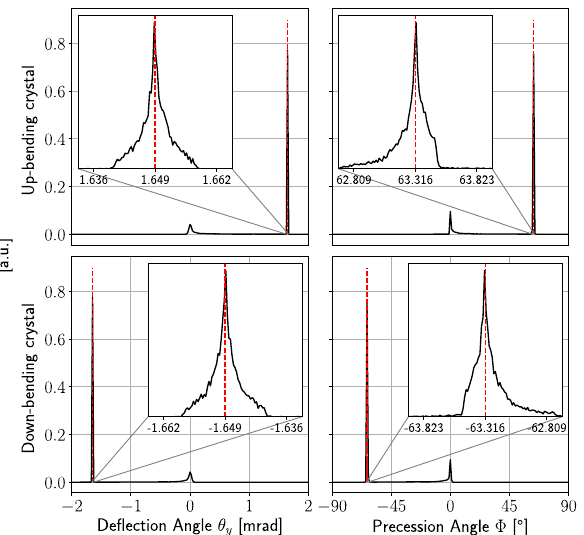
Fig. 5 Distributions of the trajectory deflection angle and spin preces- sion angle for Σ + baryons of 375GeV / c momentum interacting with 4 . 5cm long (top) up-bent and (bottom) down-bent crystals, uniformly bent along the ( 111 ) plane at ± 1 . 649mrad angle. Similar crystals were used for the E761 experiment at FNAL [55]